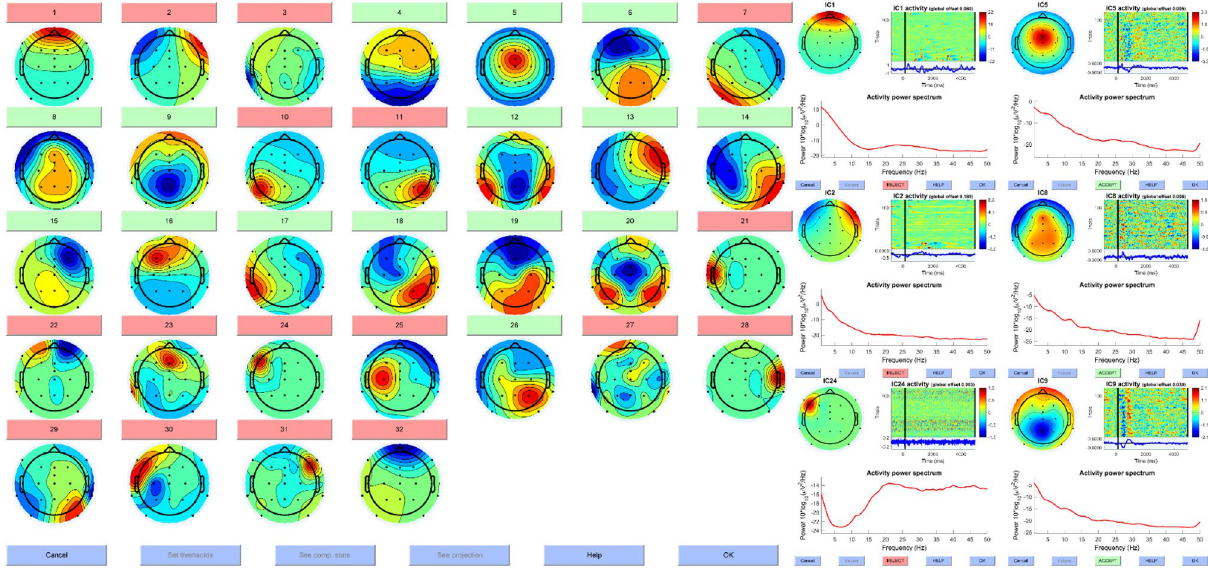
Figure 3. Independent components classified in artifact components (red) and signal components (green). Note in the right panel the frequency distribution, topography and time courses of different artifact and signal